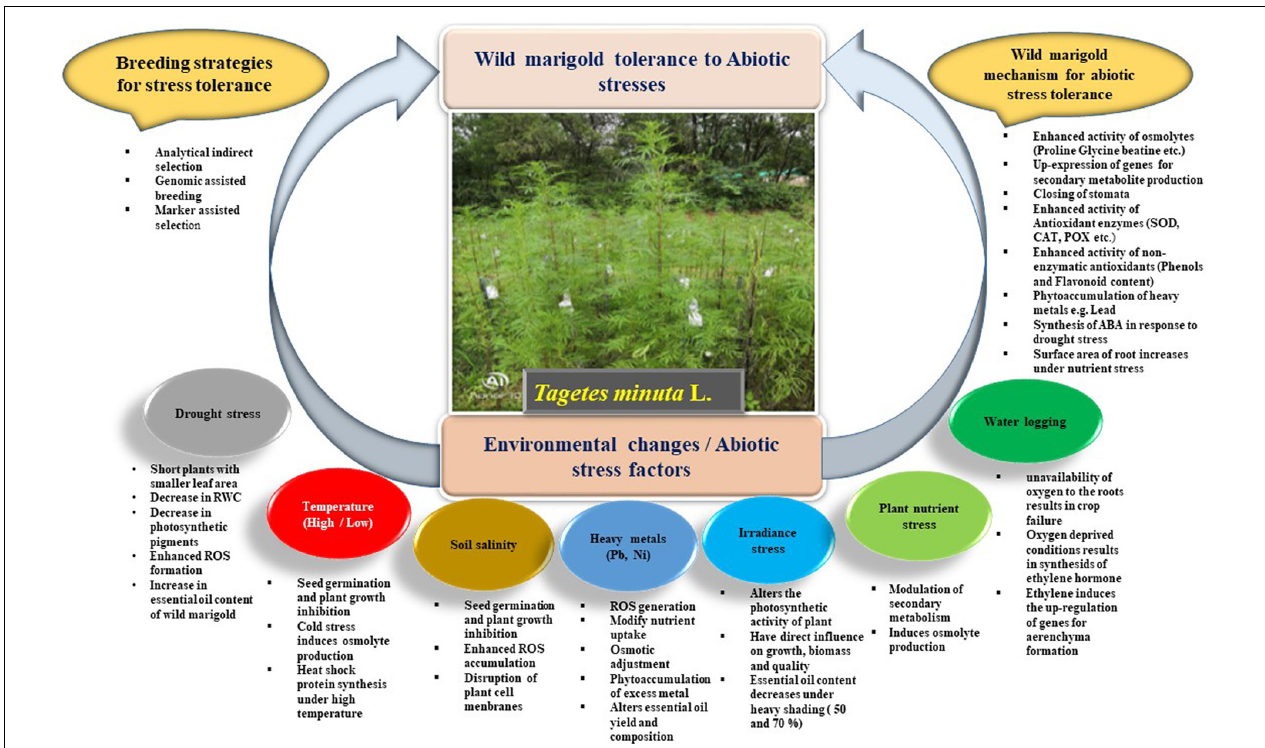
FIGURE 1 | Schematic representation of different abiotic stresses affecting morphophysiological, biochemical, and secondary metabolism of wild marigold and plant strategies to tolerate adverse environmental conditions along with breeding approaches for stress